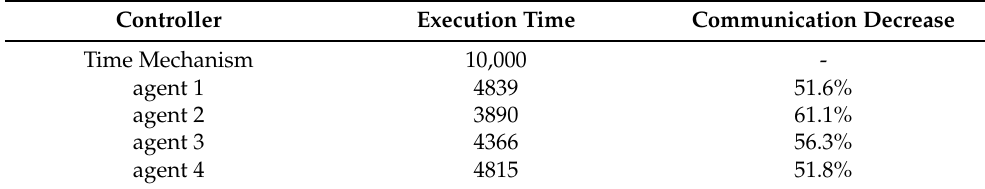
Table 1. Communication decrease for each agent.